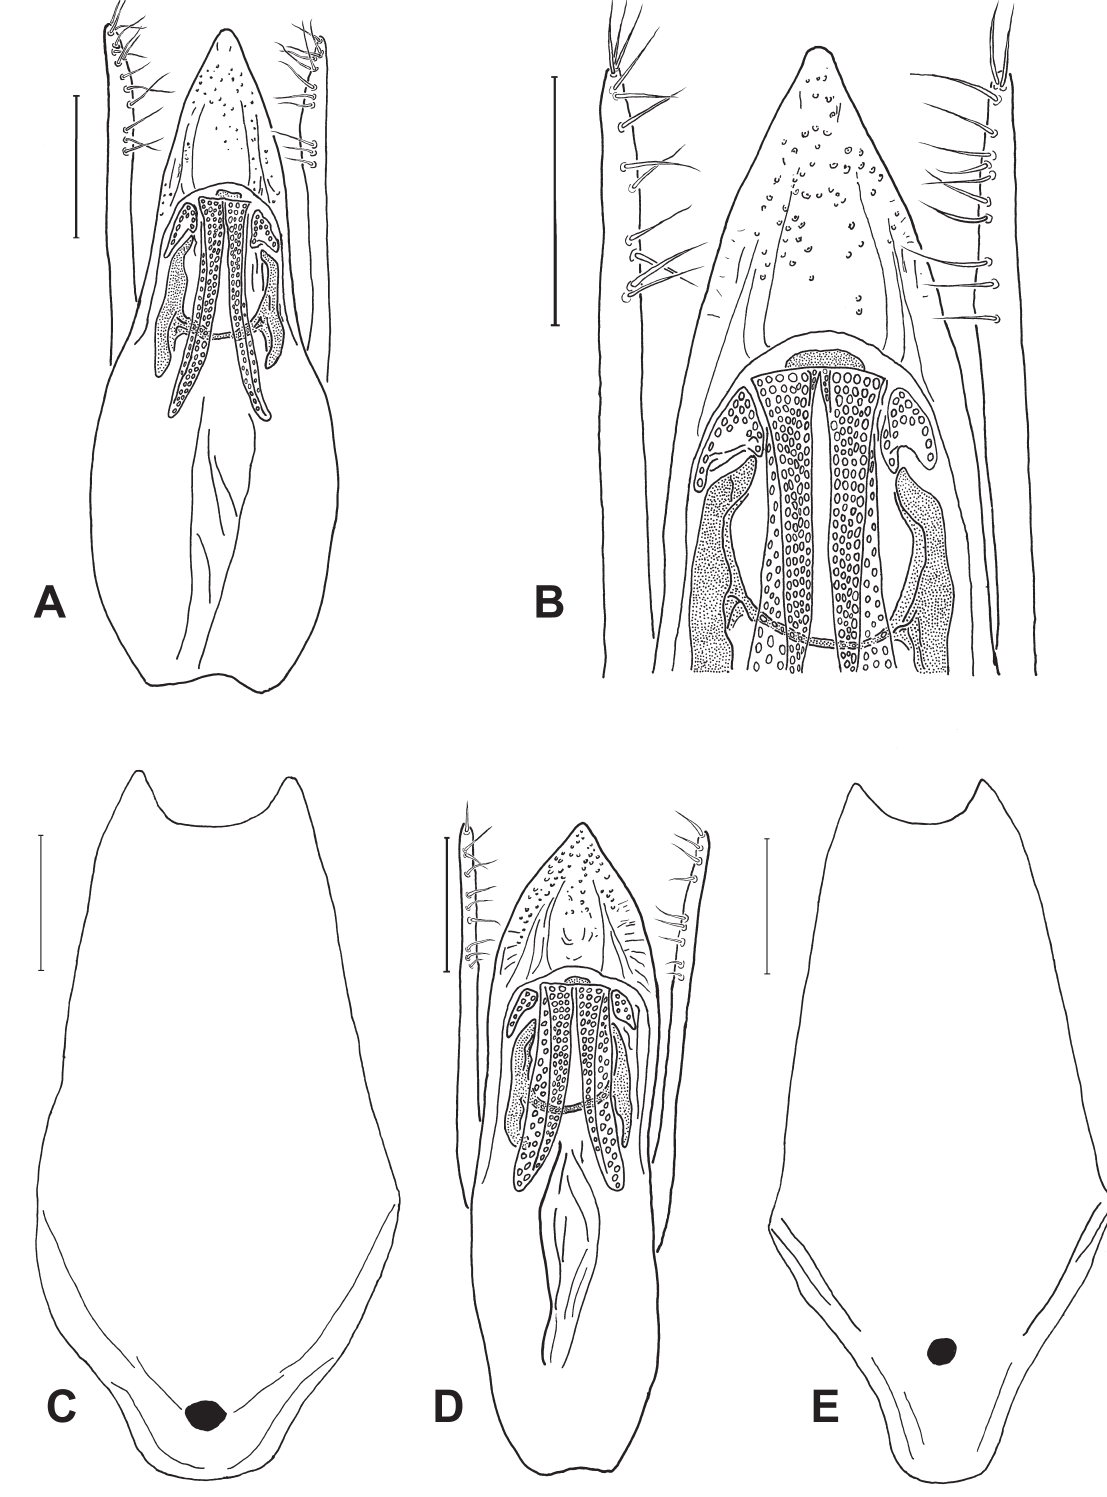
Fig. 3. – A–C : Stenus ( Nestus ) alopex sp. nov.: ♂. A . Aedeagus, ventral view (holotype). B . Apical part of aedeagus, ventral view (holotype). C . Abdominal sternite 9 (paratype). – D–E : S. ( N. ) canaliculatus Gyllenhal, 1827: ♂. D . Aedeagus, ventral view (Russia: Rostov Area: Nedvigovka). E . Abdominal sternite 9 (Russia: Taimyr: Maymecha River). – Scales = 0.1